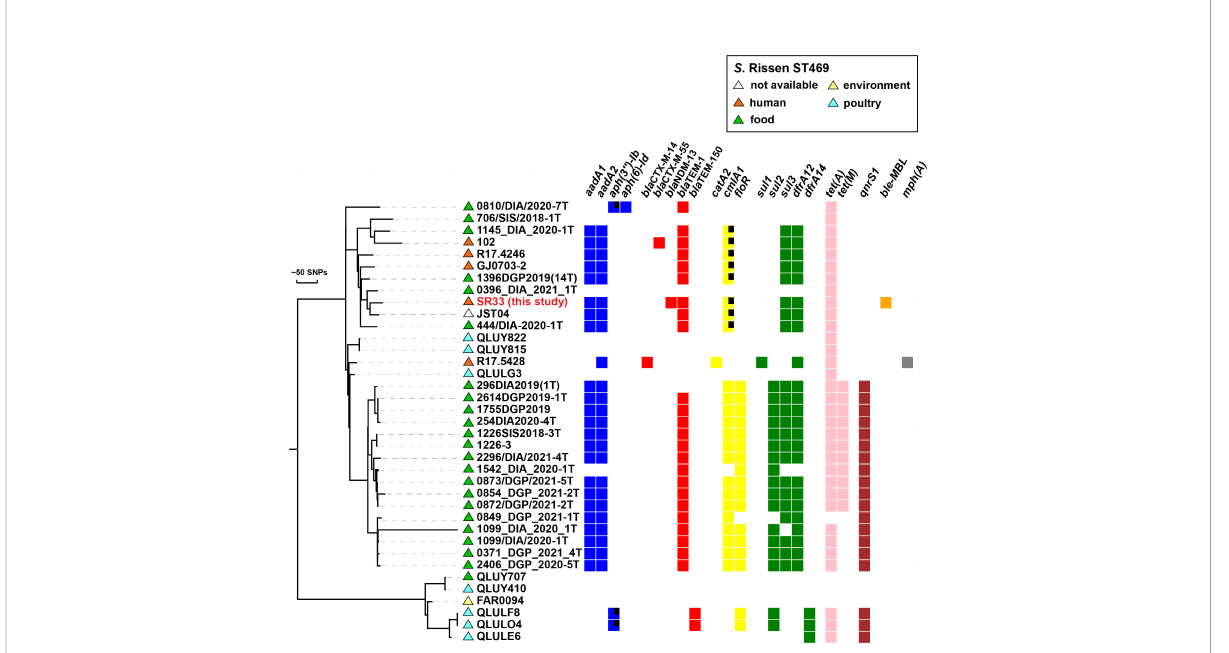
FIGURE 1 Phylogenetic distribution of antimicrobial resistance genes of SR33 of this study and other Chinese S . Rissen ST469 isolates. Antimicrobial resistant genes are represented by colored squares, genes with partial deletions are marked with black squares. The source of each isolate is shown with colored triangles. Bars represent unit distance of 50